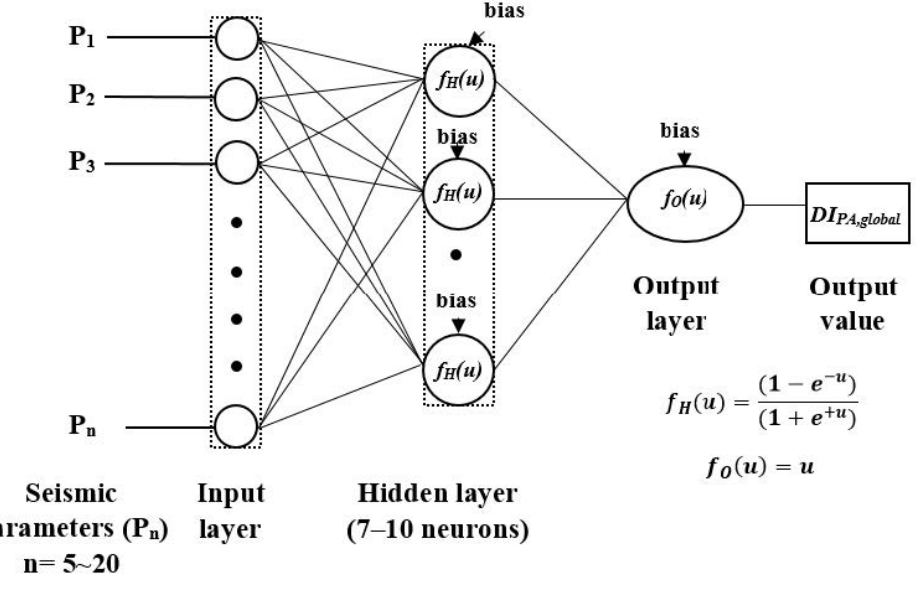
Figure 6. Schematic diagram of the developed MFPs.